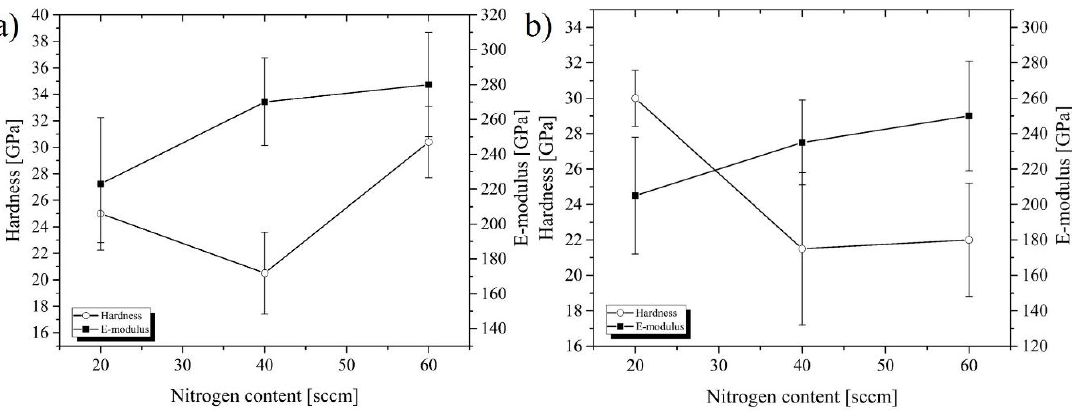
Figure 6. Influence of the nitrogen flow rate on mechanical properties of the Ti-Al-N coatings at: ( a ) 200 °C and ( b ) 500 °C.